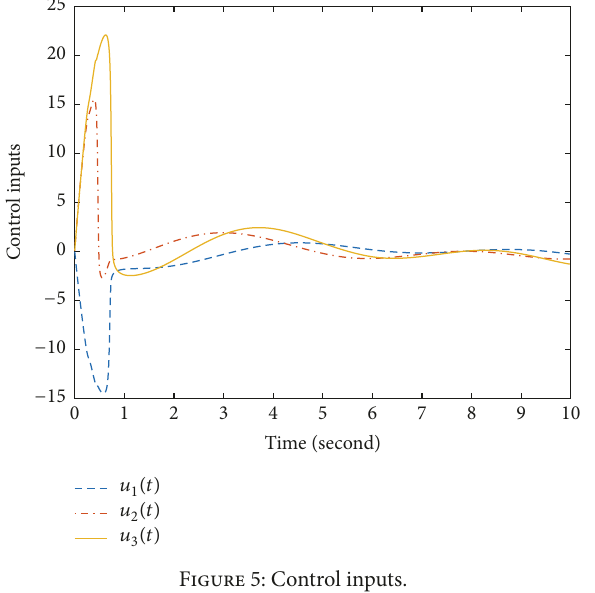
Figure 5: Control inputs.